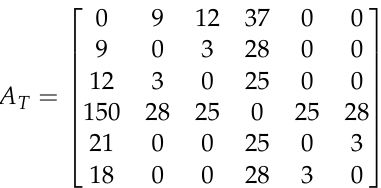
mainly due to departure issues from the port